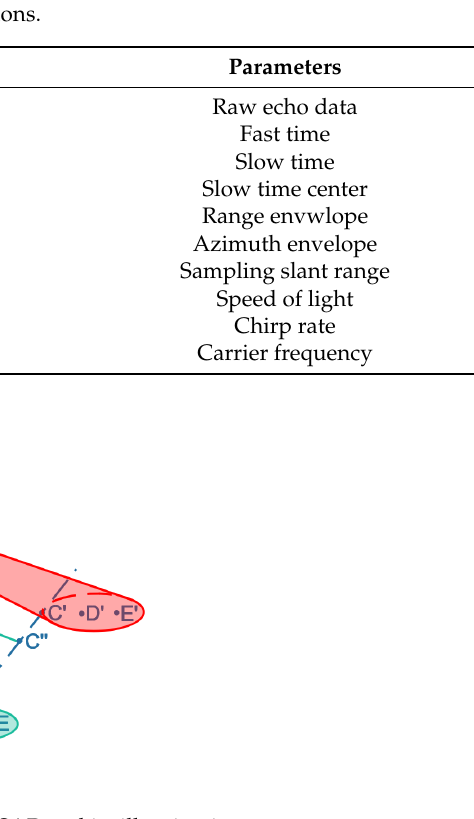
Figure 1. The geometry of the airborne VHR-SAR and its illuminating